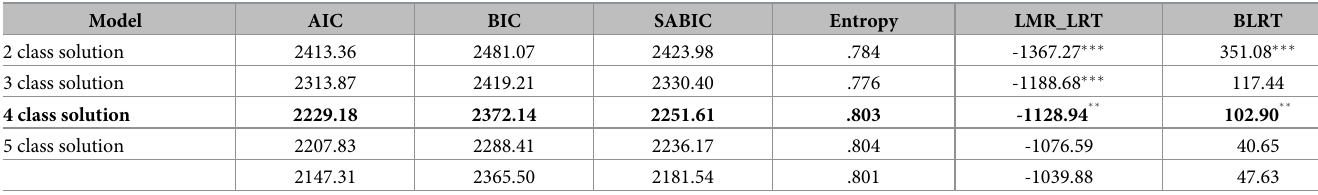
Table 2. Fit indices for one-to five class models.